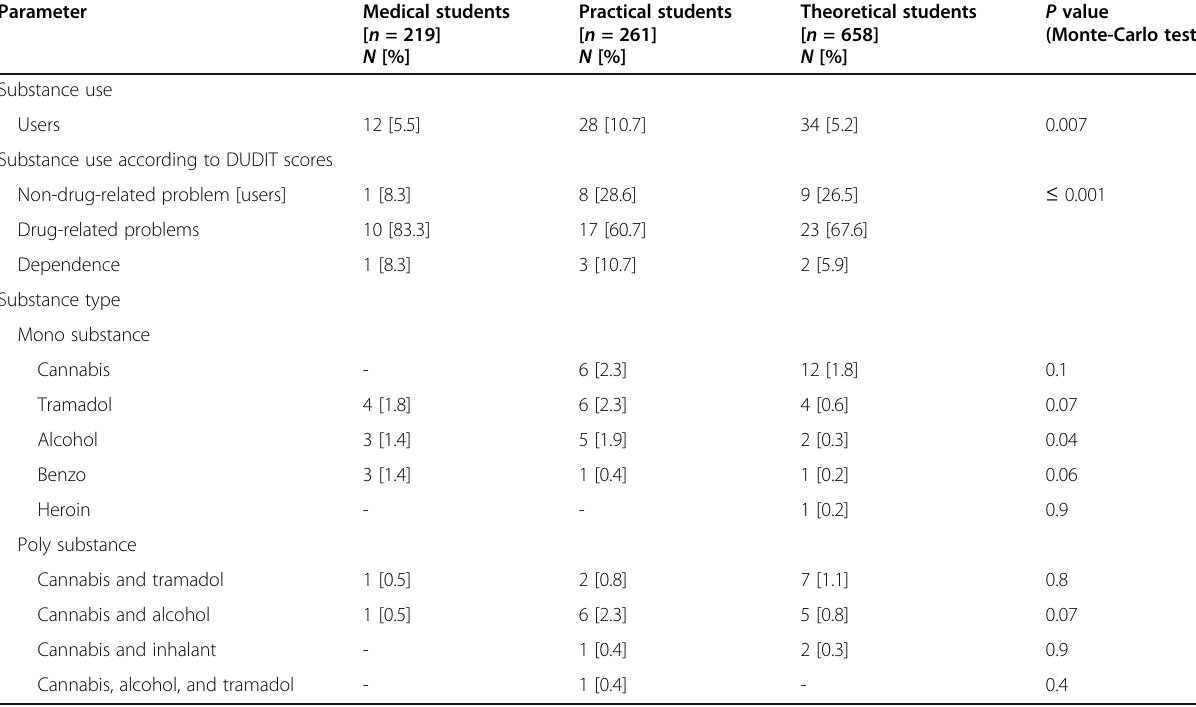
Table 3 Prevalence of substance use in medical, practical and theoretical students and DUDIT